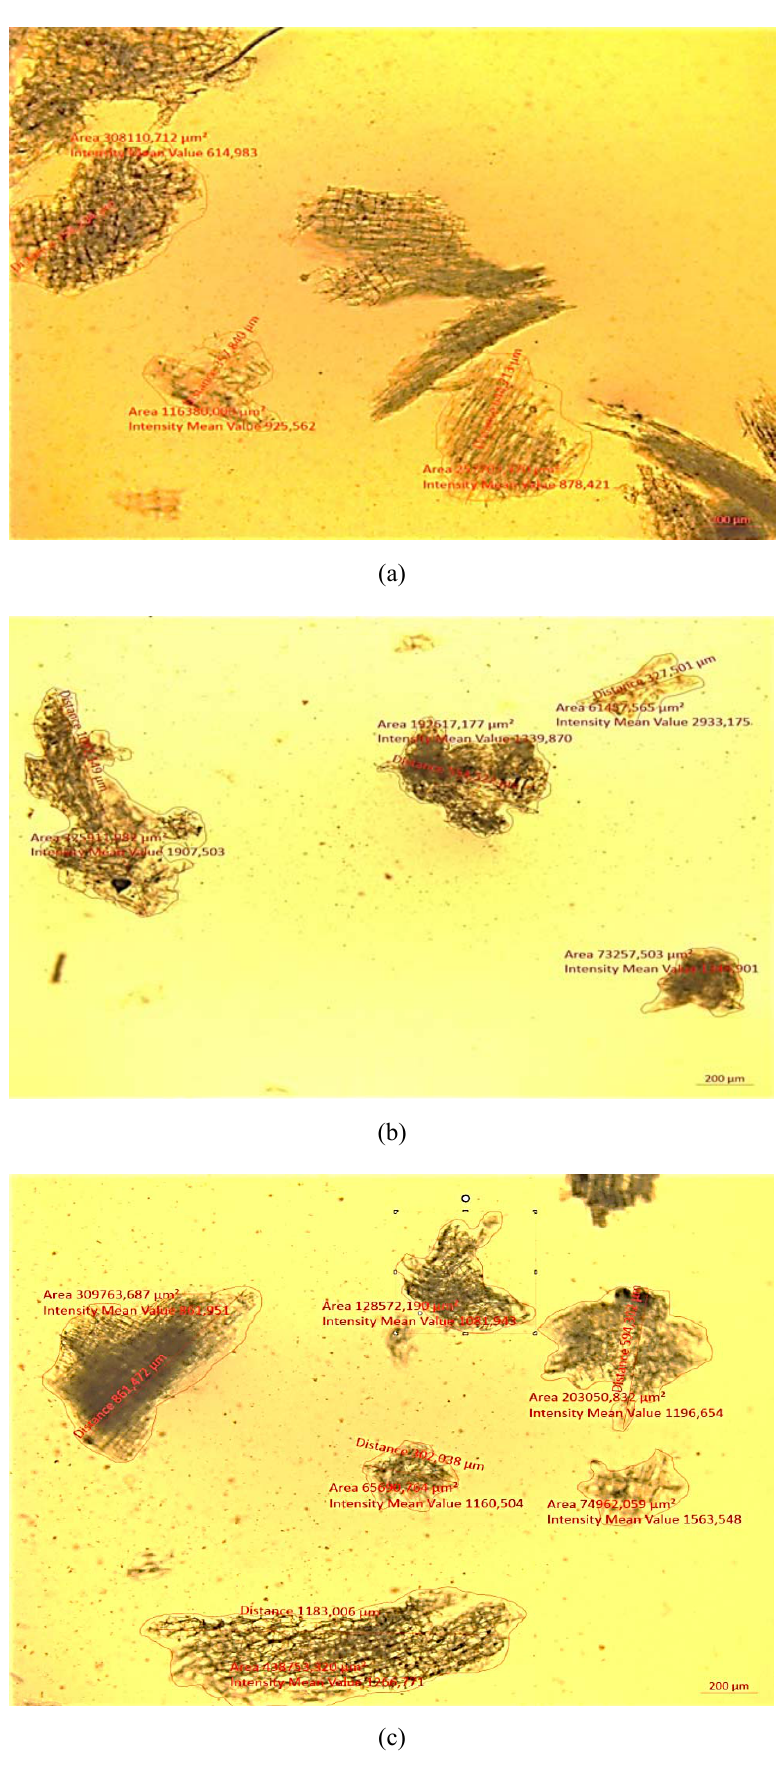
Fig. 5. Nantes, Forto and Toucheon carrots (a, b, c, respectively) after grinding using a centrifugal juicer at a screen rotation rate of 1800 rpm, a 200-fold